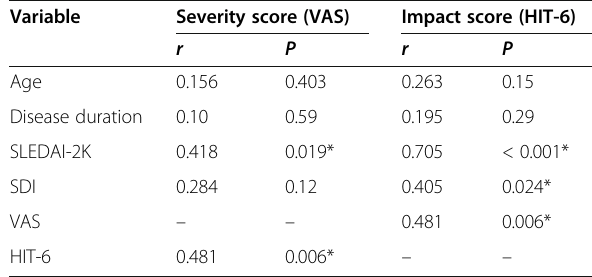
Table 3 Correlation of headache severity and impact with